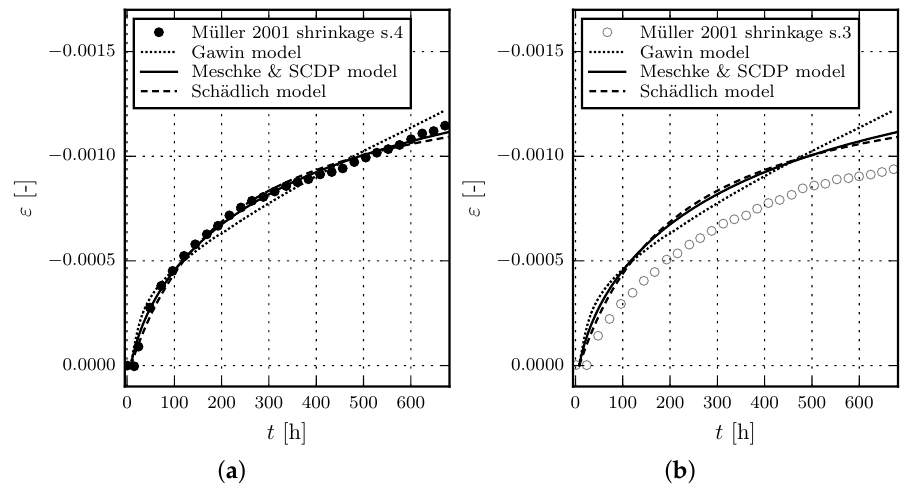
Figure 4. Evolution of the total strain in shrinkage tests: ( a ) Results of the calibration of the shotcrete models based on test data of test series 4 by Müller [17]; ( b ) Validation of the shotcrete models by means of the data of test series 3 in